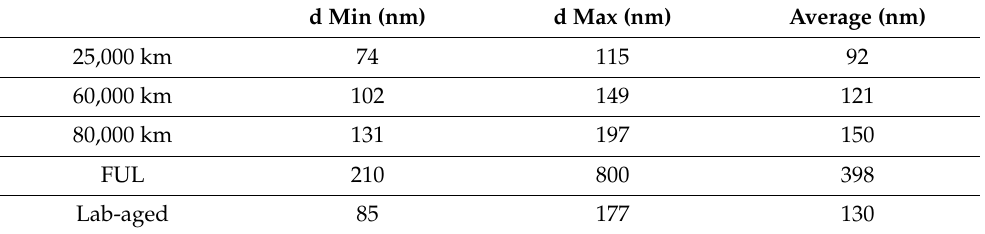
Figure 6. SEM-HR image registered on FUL sample and EDX mapping for Al, Ce, Zr and Pd recorded on the same area. Table 1. Minimum, maximum and average value of noble metal particles diameter measured via SEM. d Min